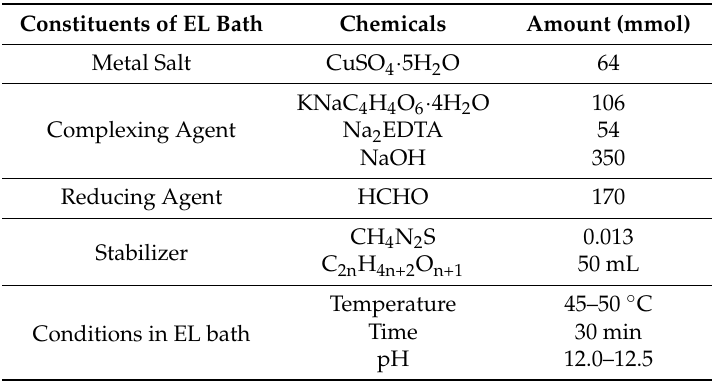
Table 1. Composition of electroless (EL) bath and conditions used for Cu